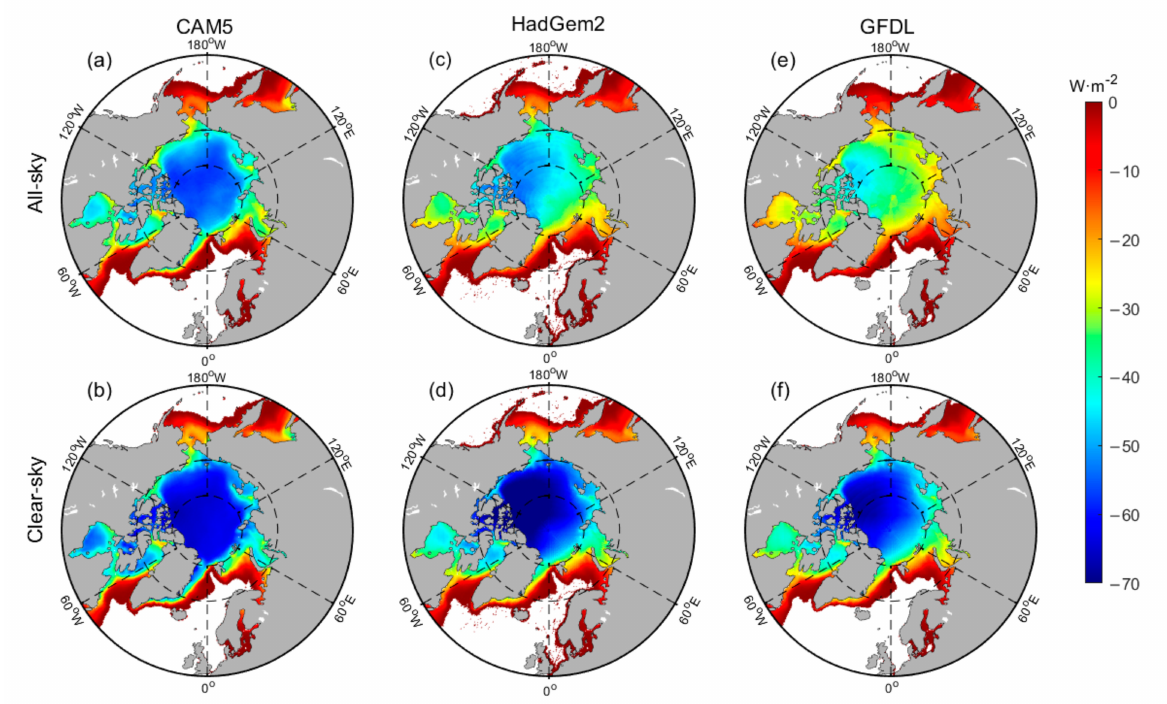
Figure 3. The annual mean spatial distribution of all-sky and clear-sky SIRFs for 1982–2020 is calculated based on APP-x and three radiative kernels. ( a ) CAM5 all-sky. ( b ) CAM5 clear-sky. ( c ) HadGem2 all-sky. ( d ) HadGem2 clear-sky. ( e ) GFDL all-sky. and ( f ) GFDL